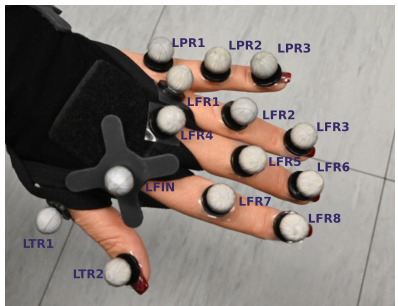
Figure 2. Left hand markers